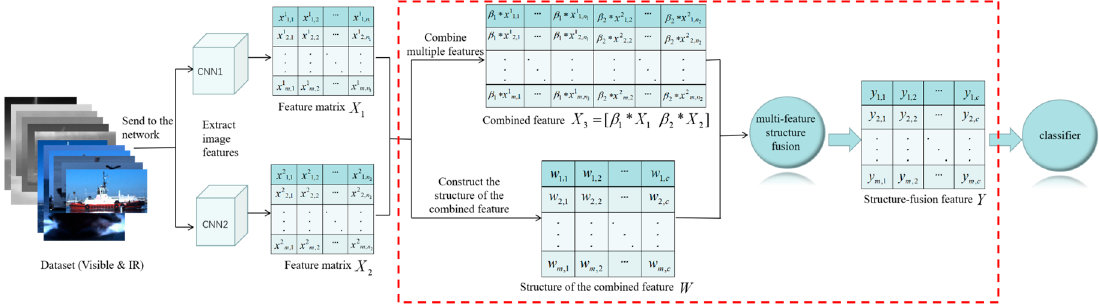
Figure 1. The overall framework of multi-feature Structure Fusion based on Spectral Regression Discriminant Analysis (SF-SRDA). CNN: convolutional neural network, IR: Infrared images.